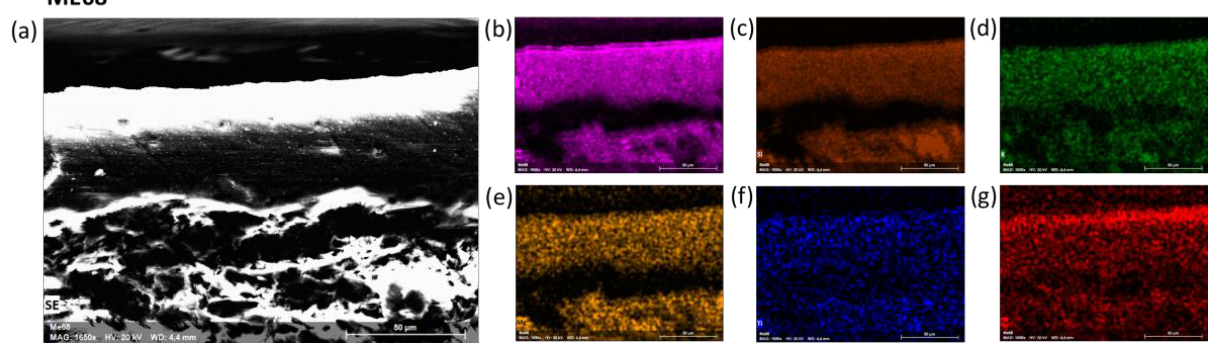
Figure 7. ( a ) SEM image of sample ME68; maps of ( b ) Al, ( c ) Si, ( d ) K, ( e ) Mg, ( f ) Ti and ( g ) Fe.